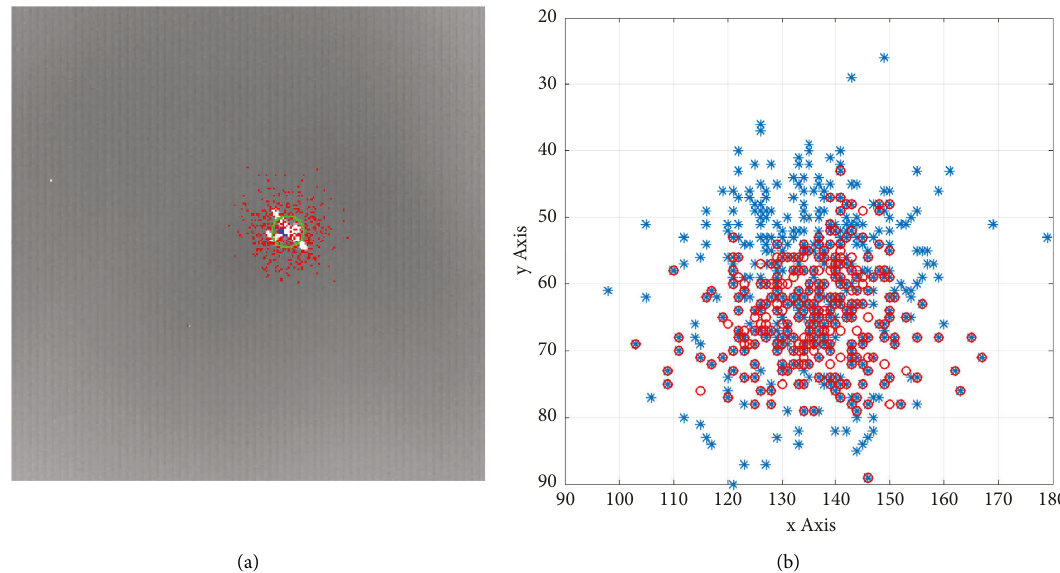
Figure 3: Infrared target characteristics detection. (a) Close target detection. (b) Particle distributions before and after